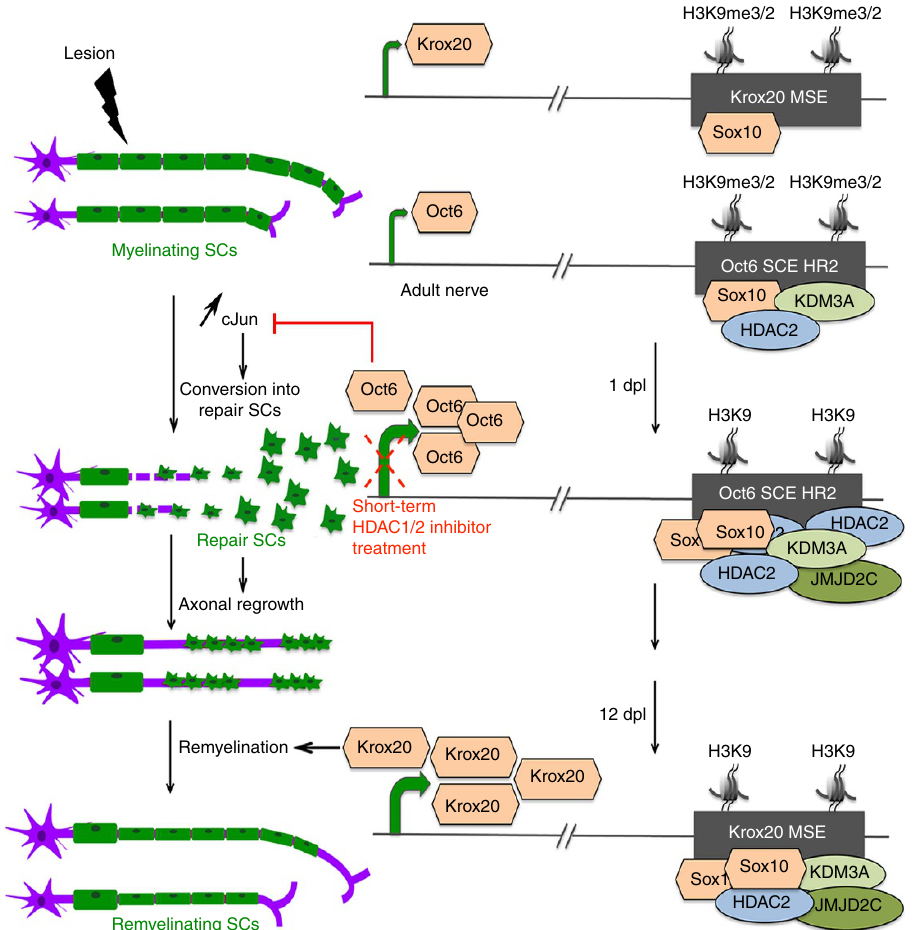
Figure 10 | Mechanism of Oct6 and Krox20 de-repression after lesion. In myelinating SCs of adult peripheral nerves, low levels of Sox10 are bound to the Krox20 MSE, which is methylated at H3K9, and low levels of Krox20 are expressed. Oct6 is also weakly expressed, and KDM3A and low levels of Sox10 and HDAC2 are bound to the Oct6 SCE HR2, which is methylated at H3K9. In case of lesion, HDAC2, Sox10 and JMJD2C are recruited to the Oct6 SCE HR2 at 1 dpl to demethylate H3K9 and activate Oct6 expression. Upregulated Oct6 at 1 dpl slows down the upregulation of cJun, which induces the conversion of mature SCs into repair SCs and thereby promotes axonal regrowth. This mechanism can be inhibited by a short-term HDAC1/2 inhibitor treatment, which results in faster conversion into repair SCs and faster axonal regrowth. At 12 dpl, Sox10, HDAC2, KDM3A and JMJD2C are recruited to the Krox20 MSE